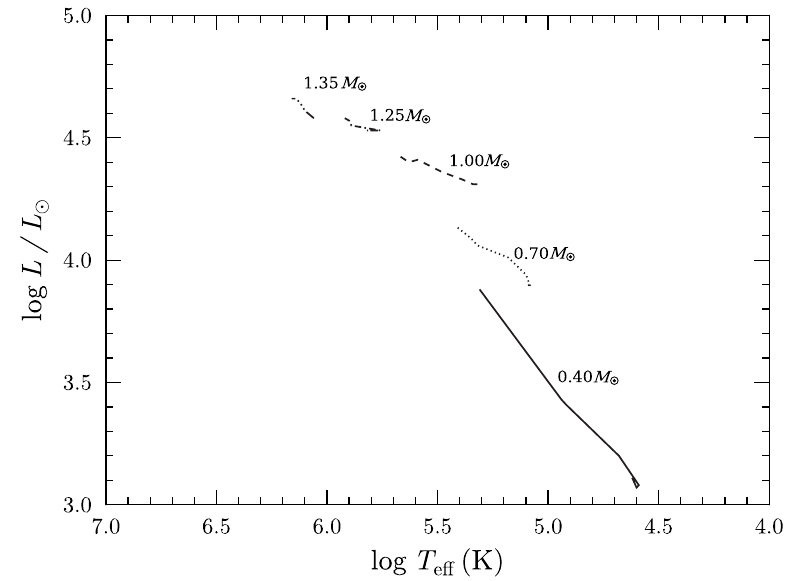
Fig. 6. This is the same plot as in Figure 5 but for the peak conditions during the thermonuclear runaway. Again, the mass accretion rate is increasing from lower effective temperatures to higher effective temperatures. All but those occurring on the lowest mass WDs would be detected by current X-ray satellites but those on the highest mass WDs, and thus closest to the Chandrasekhar Limit, would be detected for the shortest amount of